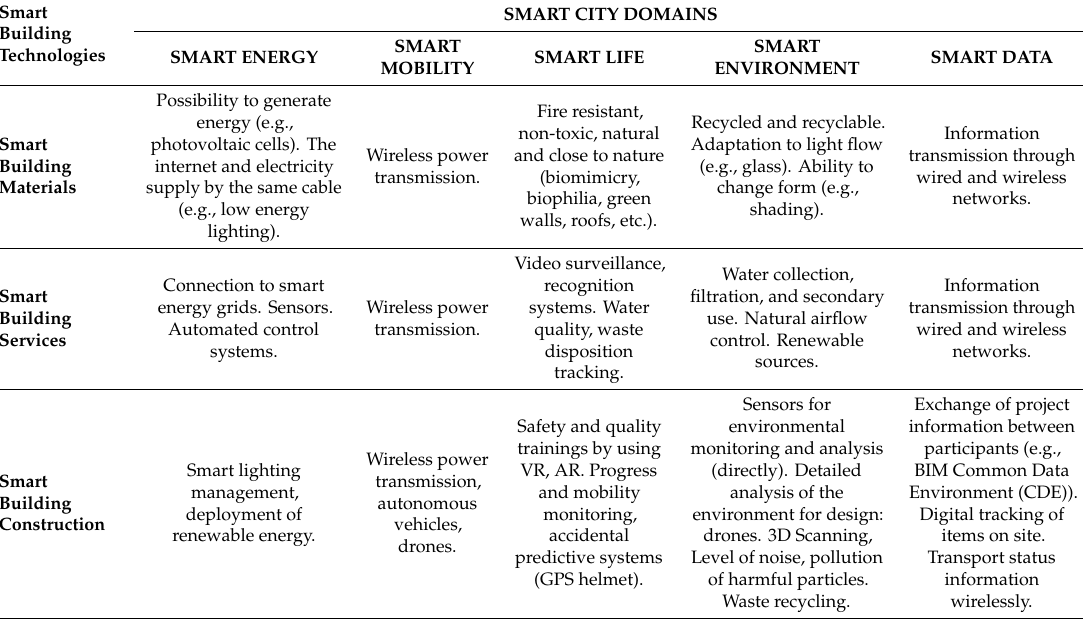
Table 8. Smart building application examples in relation to smart city